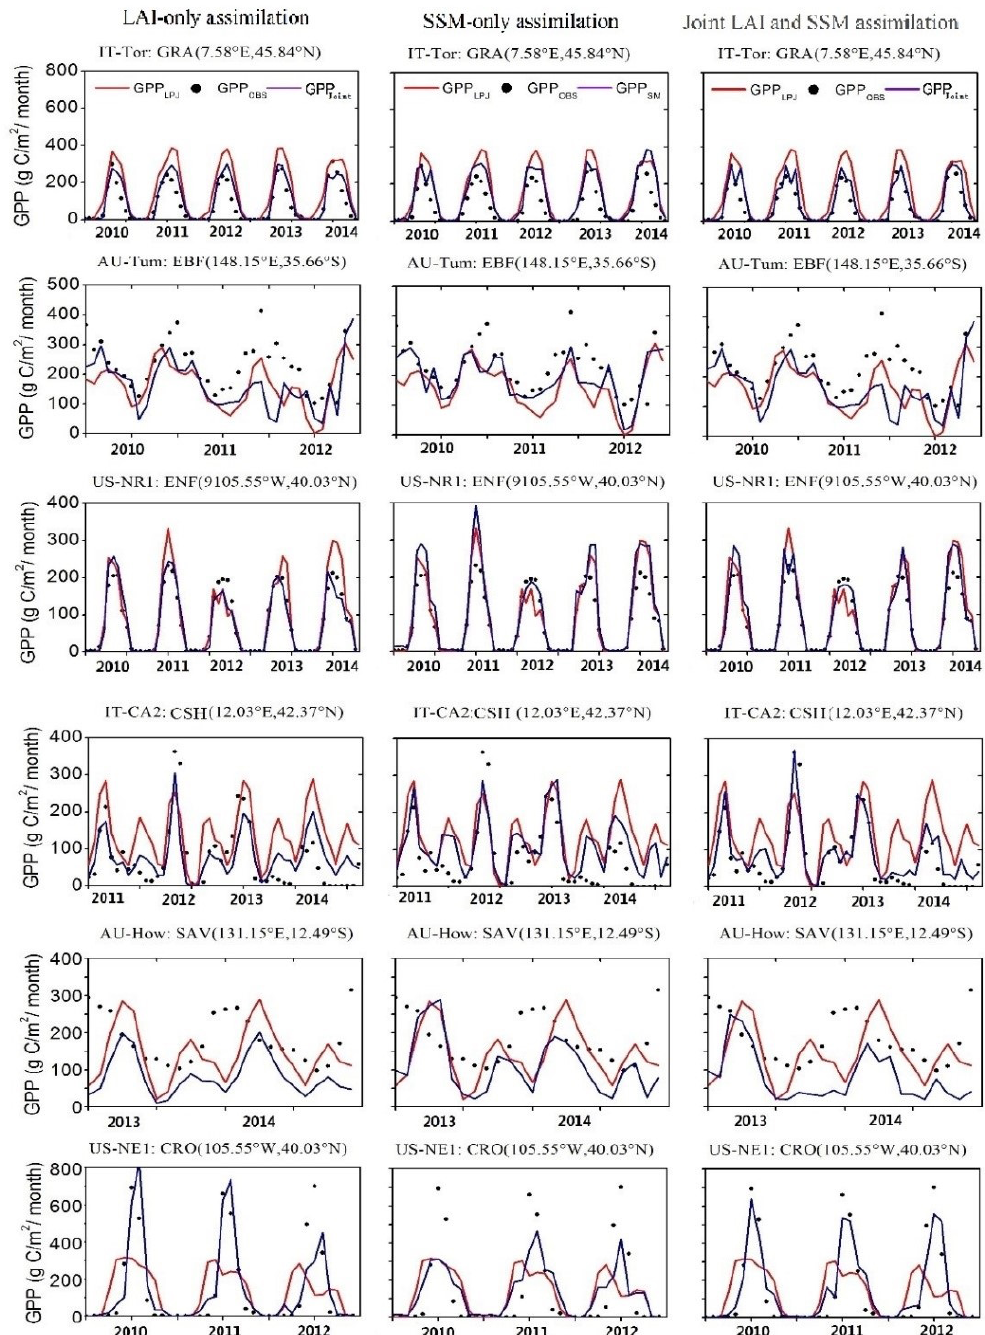
Figure 3. Seasonal cycles of tower GPP and simulated gross primary productivity (GPP) from Lund–Potsdam–Jena (LPJ), LAI-only assim- ilation, SSM-only assimilation, and joint assimilation for six sites representing six